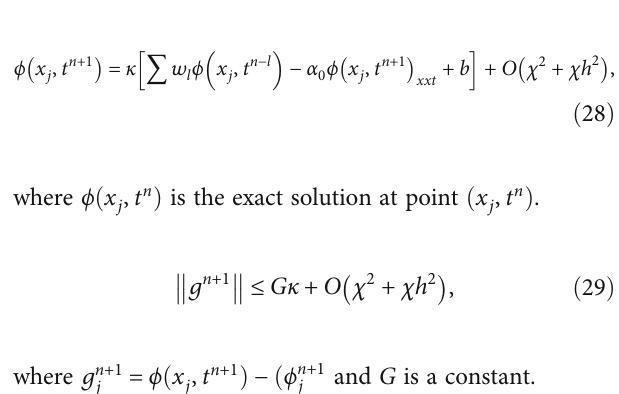
Figure 2: Exact and numerical results of time fractional BBMB- equation for t = 0 : 75 , 2.5, and 5, α = 0 : 5 , Δ t = 0 : 011 , β = 1 , and h = 0 : 01 :